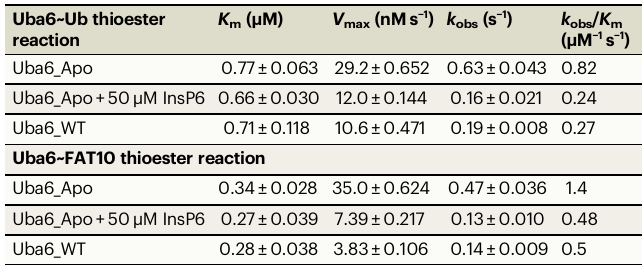
Table 1 | Estimates of K m and k obs for Uba6~Ubl thioester formation assays Uba6~Ub thioester